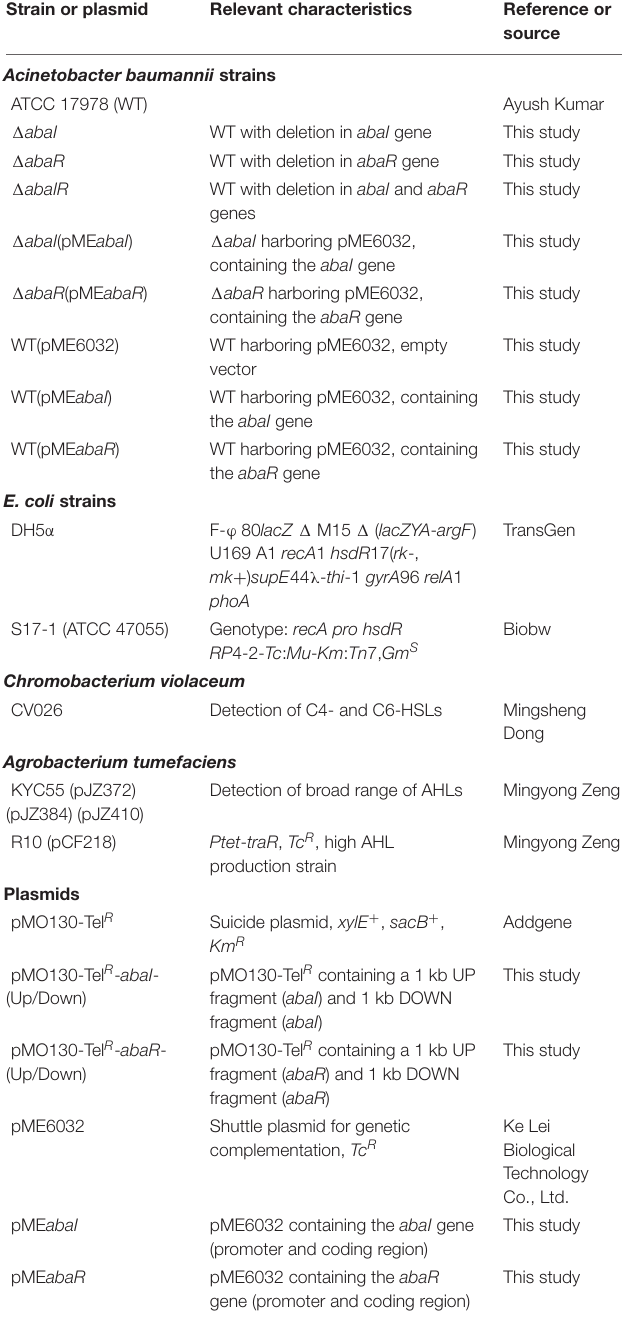
TABLE 1 | Bacterial strains and plasmids used in this